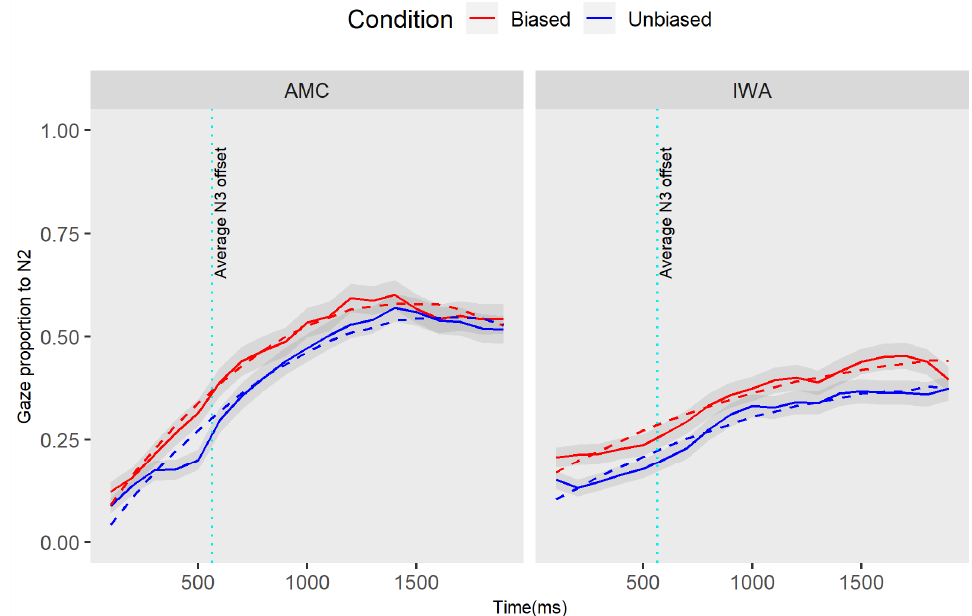
Figure A1. Gaze proportion differences toward N3 between conditions and groups. Solid lines represent observed data and dashed lines represent the GCA model fit.